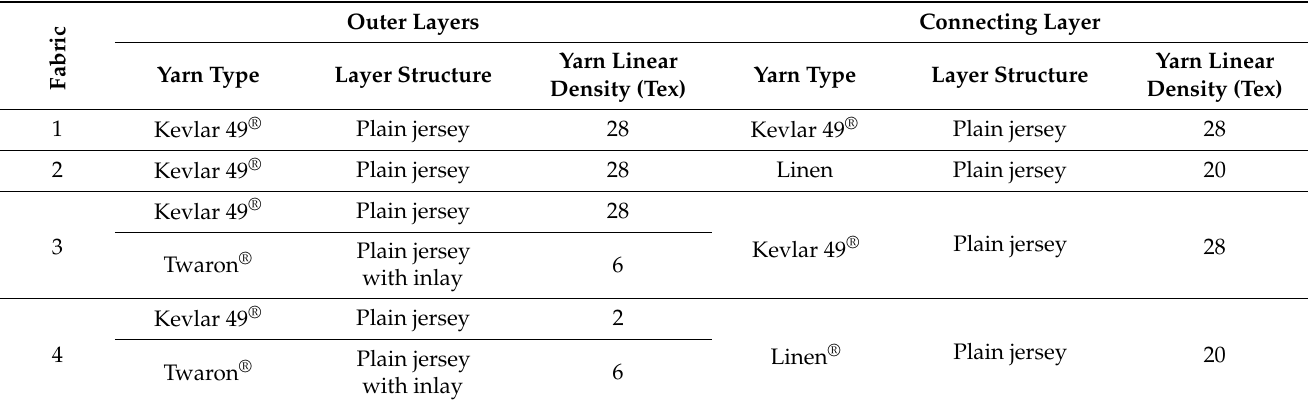
Table 1. Characterisation of the experimental variants (weft knitted spacer fabrics).